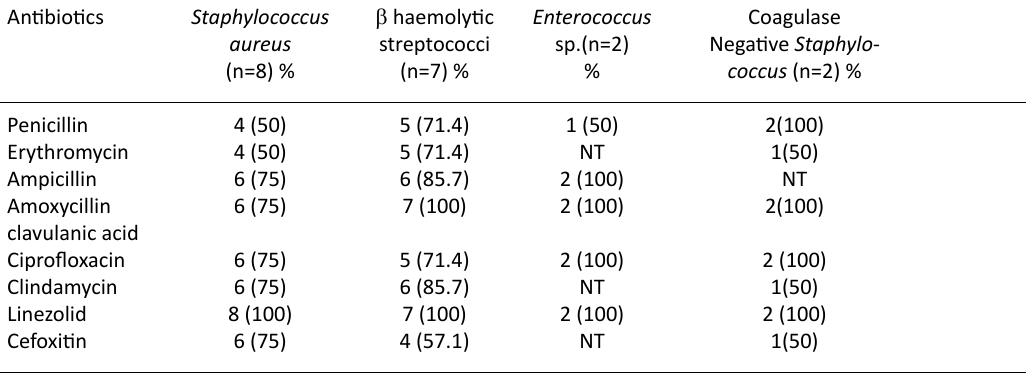
table 3. Percentage of sensitivity of Gram positive organisms to various antibiotics Antibiotics Staphylococcus β